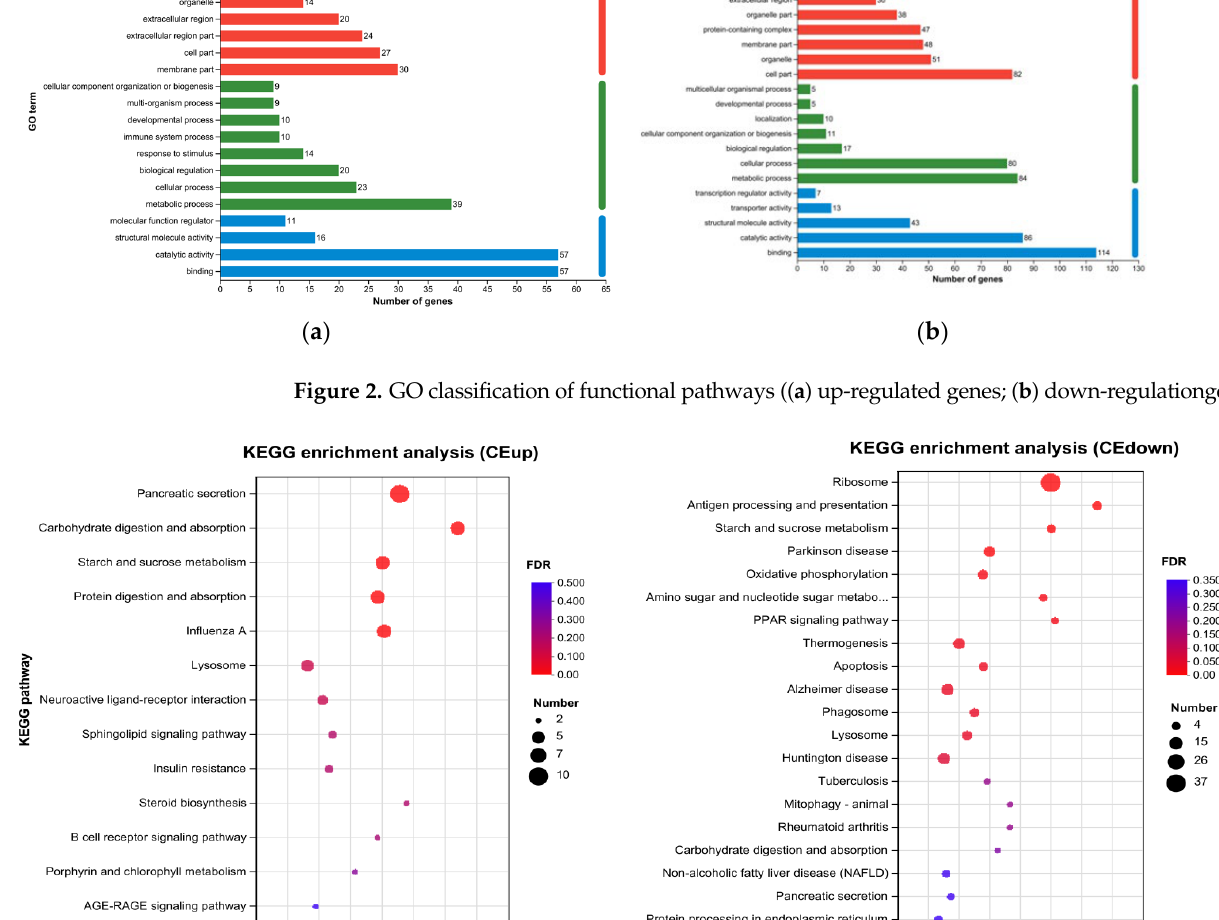
8 of 15 Figure 2. GO classification of functional pathways (( a ) up-regulated genes; ( b ) down-regula- tiongenes). According to KEGG analysis, among the top-20 pathways that were significantly up- regulated, it was found that the pathways related to metabolism, growth, and metabolism of M. mongolica were starch and sucrose metabolism (Figure3a), lysosome, the neuroactive ligand-receptor interaction, and the sphingolipid-signaling pathway. Pancreatic secretion, carbohydrate digestion and absorption, protein digestion and absorption, and the B cell receptor-signaling pathway were primarily related to the digestion of M. mongolica , in